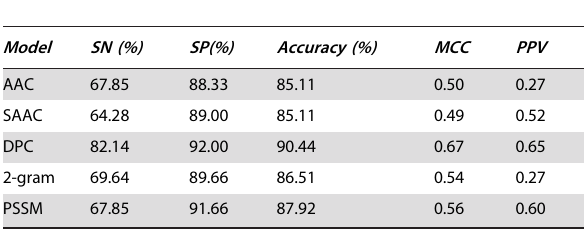
Table 2. Performance of best ANN classifiers in LOO